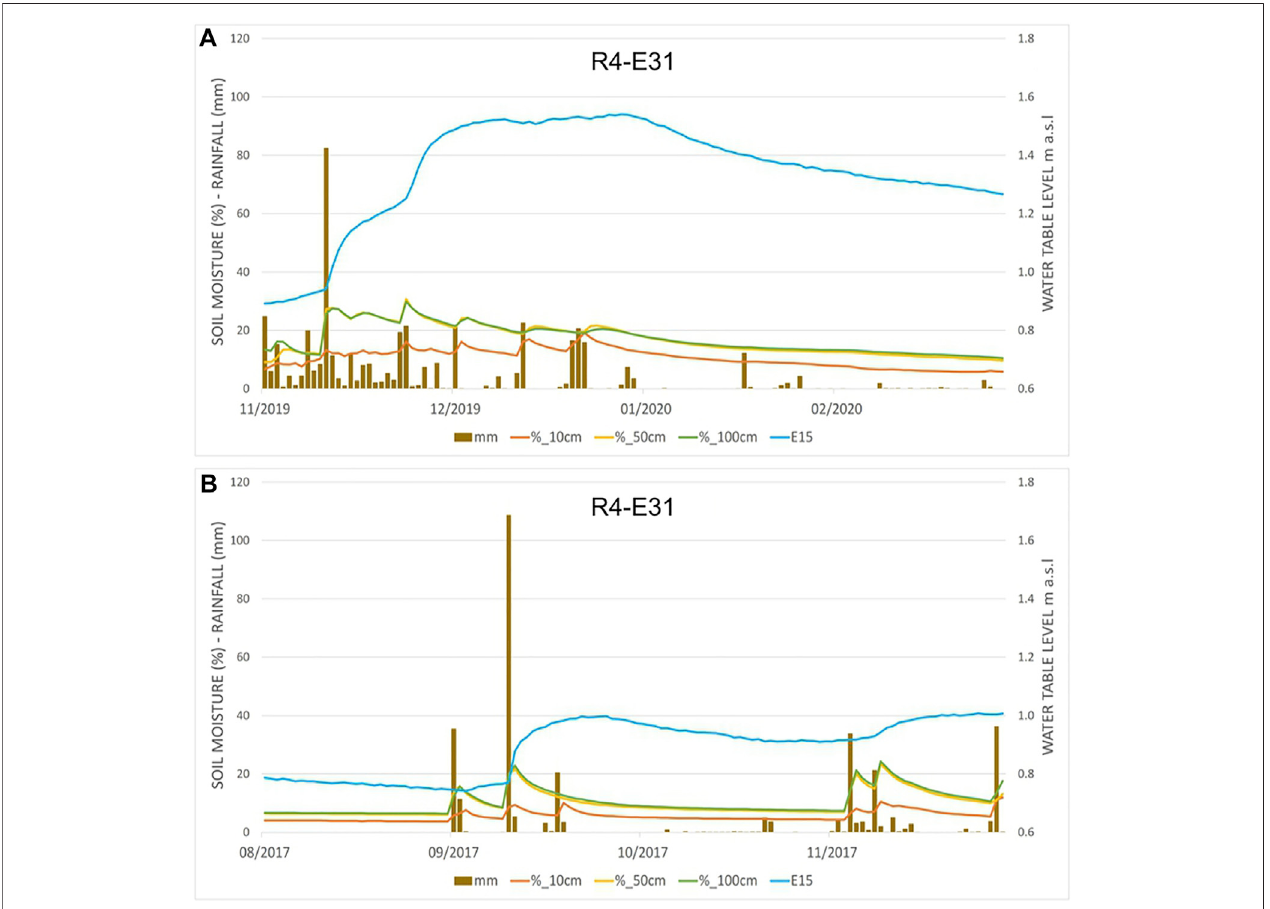
FIGURE 13 | Comparison of rainfall daily data, soil moisture percentage at different depths measured in the R4-Grotte di Piastra gauging station, and water table level in the E31 monitoring well for the November heavy event (A) and the September heavy event (B) .